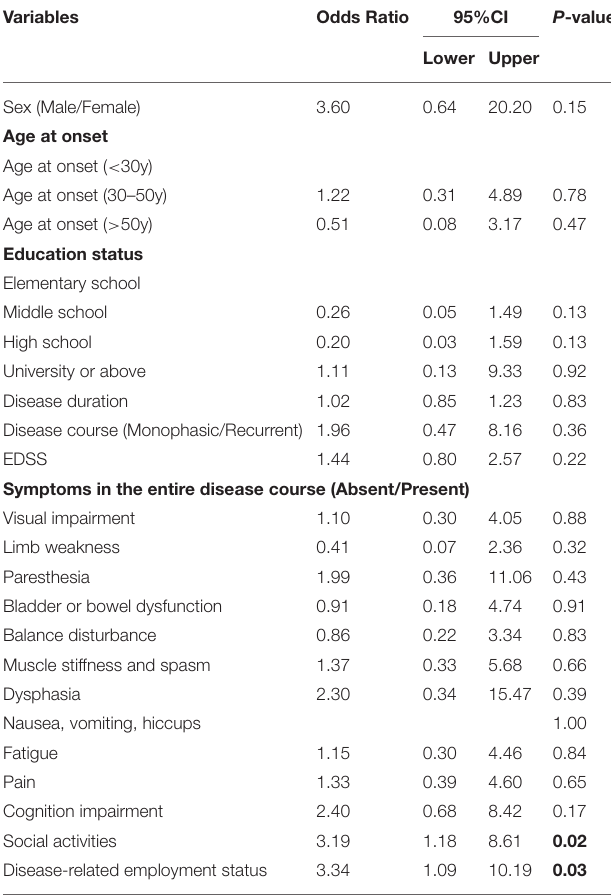
TABLE 5 | Binary logistic regression analysis of factors associated with negative emotions (Absent vs. Present).